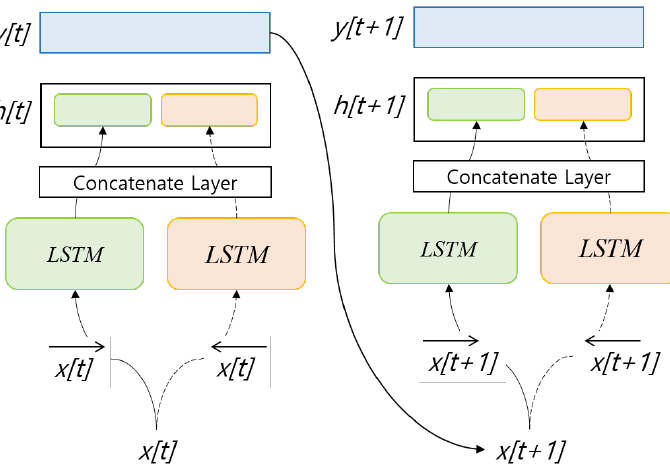
Figure 5. Example of Bi-directional LSTM network nodes. This study used the feature vectors discussed in Section 4.1 and a bi-directional LSTM to recognize emotions from speech. Figure 6 shows the bi-directional LTSM model em- ployed.